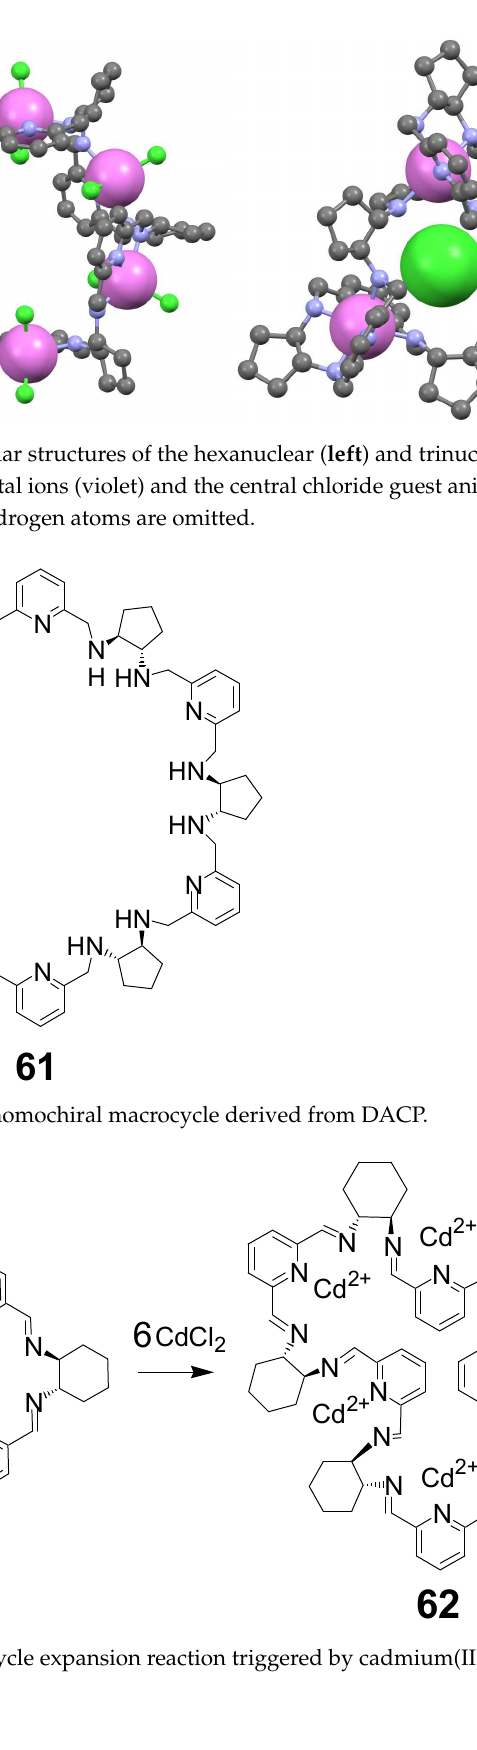
Figure 27. Top —structure of protonated [6 + 6] amine 59 embracing two chloride anions and two water molecules. Bottom —structure of protonated [8 + 8] amine 60 embracing two sulfate anions (chlorides, sulfates and water molecules are shown in spacefill representation, hydrogen atoms are omitted).